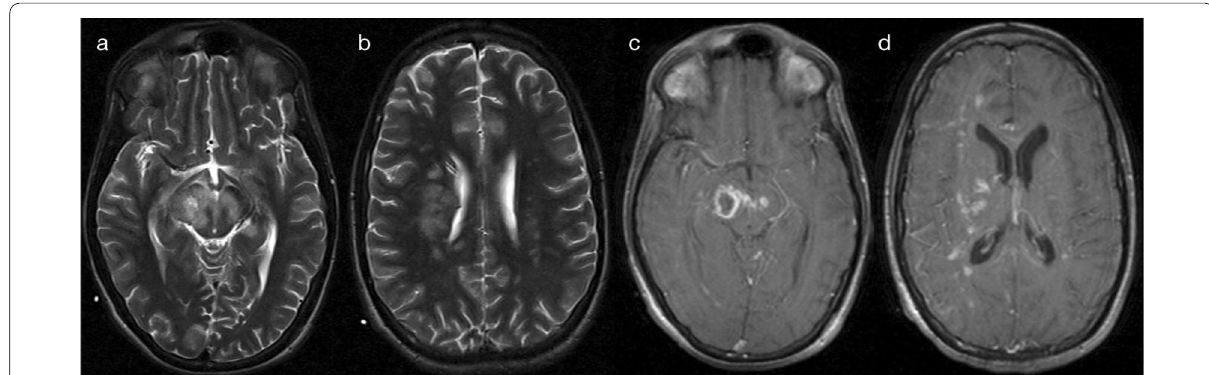
Fig. 18 T2 hyperintensity in posterior fossa—diffuse brainstem with longitudinal tract involvement (Pattern 6B). Follow‑up MRI after 2 weeks (same patient as Fig. 17 with biopsy‑proven neuromelioidosis) showed T2 hyperintensities ( a , b ) following longitudinal white matter tracts into the supratentorial brain. Post‑contrast T1‑weighted imaging ( c , d ) demonstrated a rim‑enhancing abscess in the right cerebral peduncle and multiple enhancing foci in the supratentorial brain (representing micro‑abscesses)